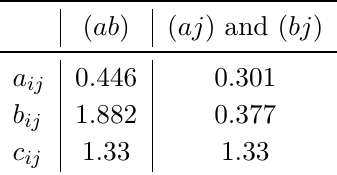
Table 1 . Fitting parameters for the resummed NGLs for anti- k t clustering with R = 0 . 5